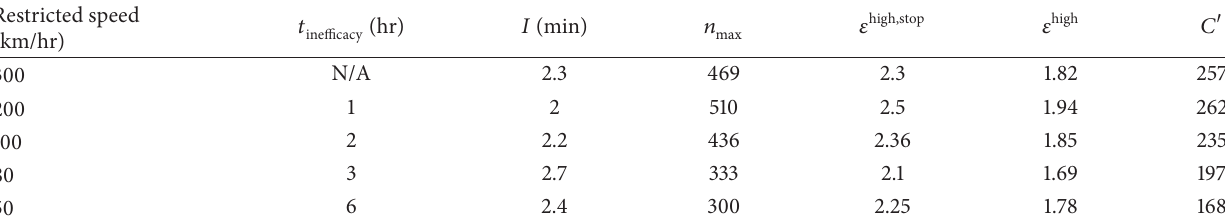
Table 3: Capacity of Hu-Ning part in speed restrictions.